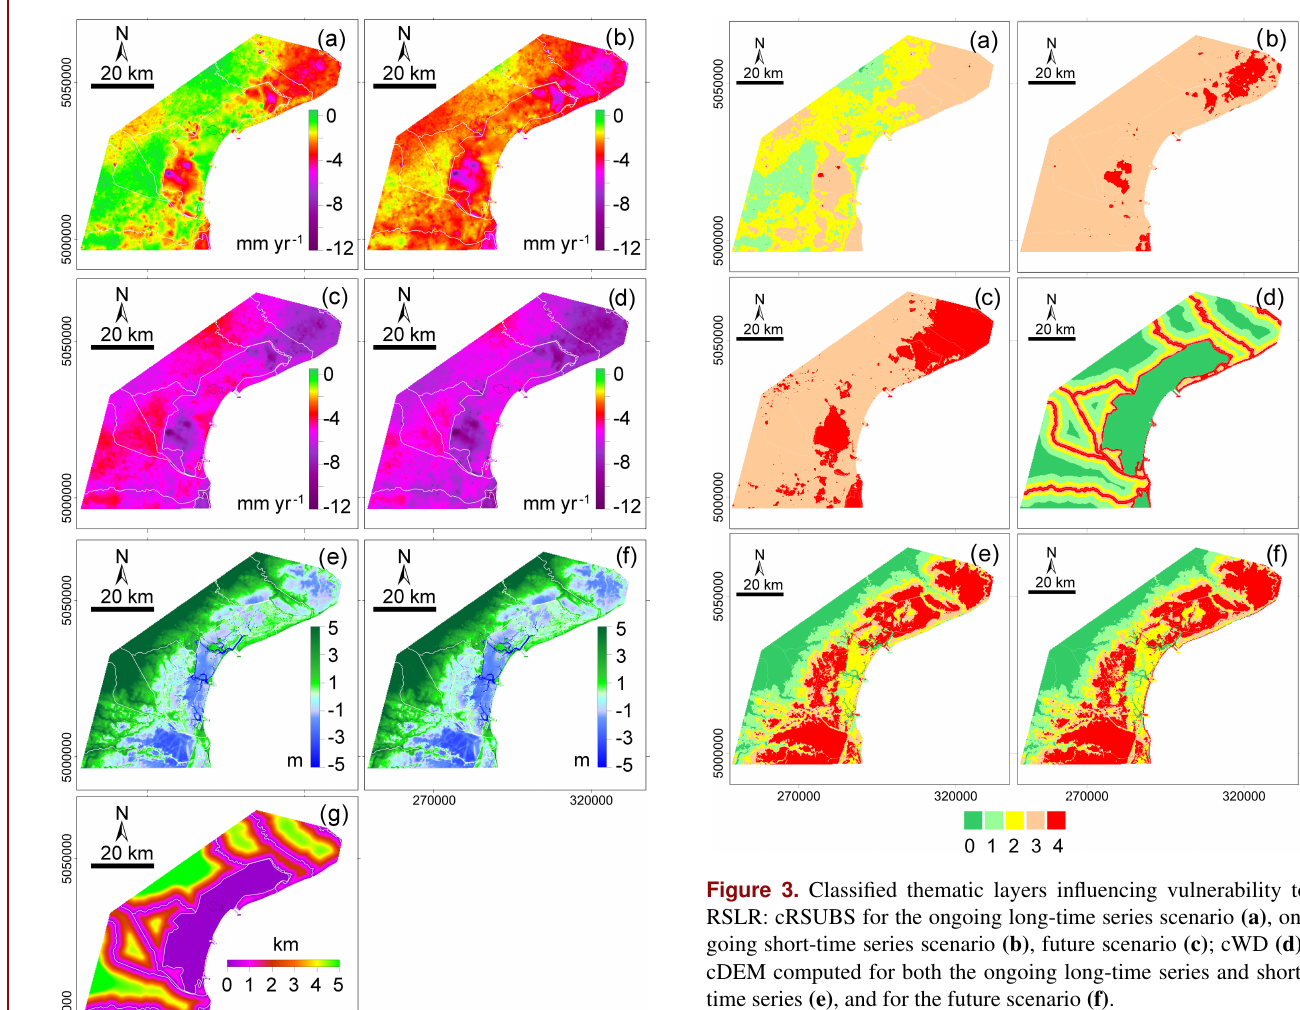
with respect to the sea